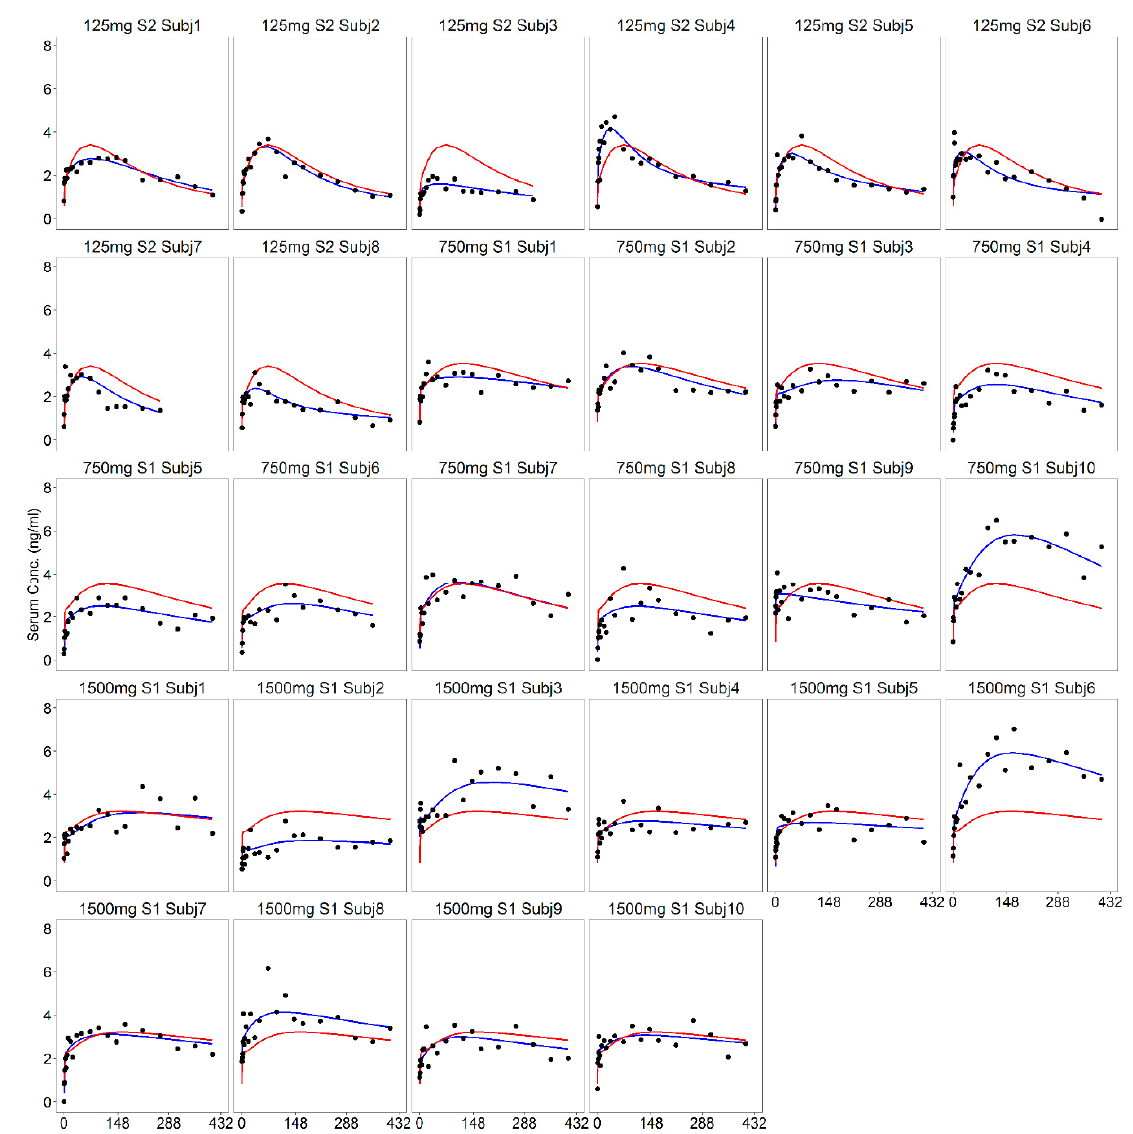
Figure A1. Model predictions of the individual (blue lines) and population (red lines) serum concentration profiles at 750 and 1500 mg dose levels together with observations (black dots).